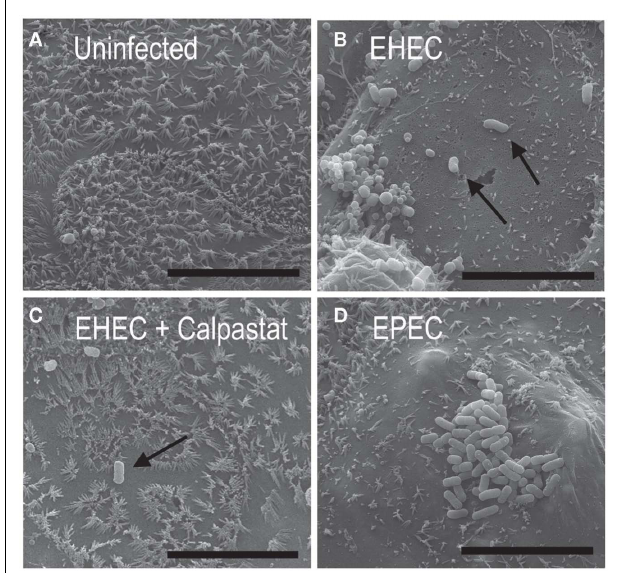
FIGURE 3 |A cell-penetrating calpain inhibitor prevents microvilli effacement by EHEC. Uninfected CaCo-2a CON monolayers (A) and monolayers infected for 2h with EHEC without (B) or with (C) 1h pretreatment with 2.5 μ M Calpastat, or infected with EPEC (D) were visualized by SEM at 10,000 × magnification with a 30˚ tilt. Scale bars are 10 μ m.